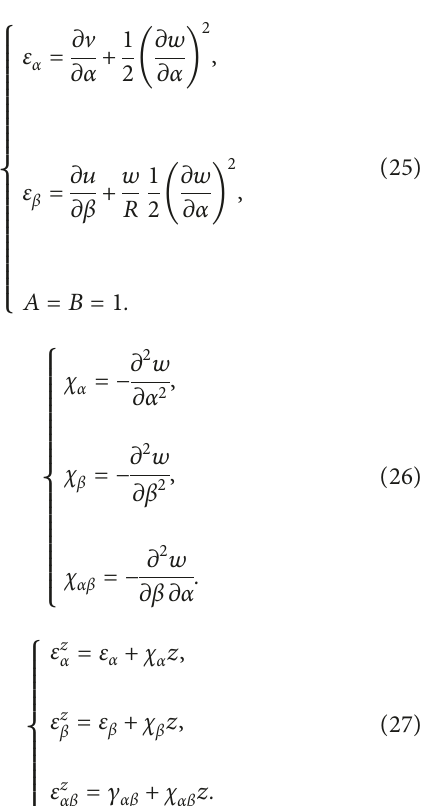
Figure 18: Comparisons of deformation energy ( E ) PT in different simulation conditions. (a) Intensity of 1500kg TNT equivalent mass explosion. (b) Intensity of 380kg TNT equivalent mass explosion.